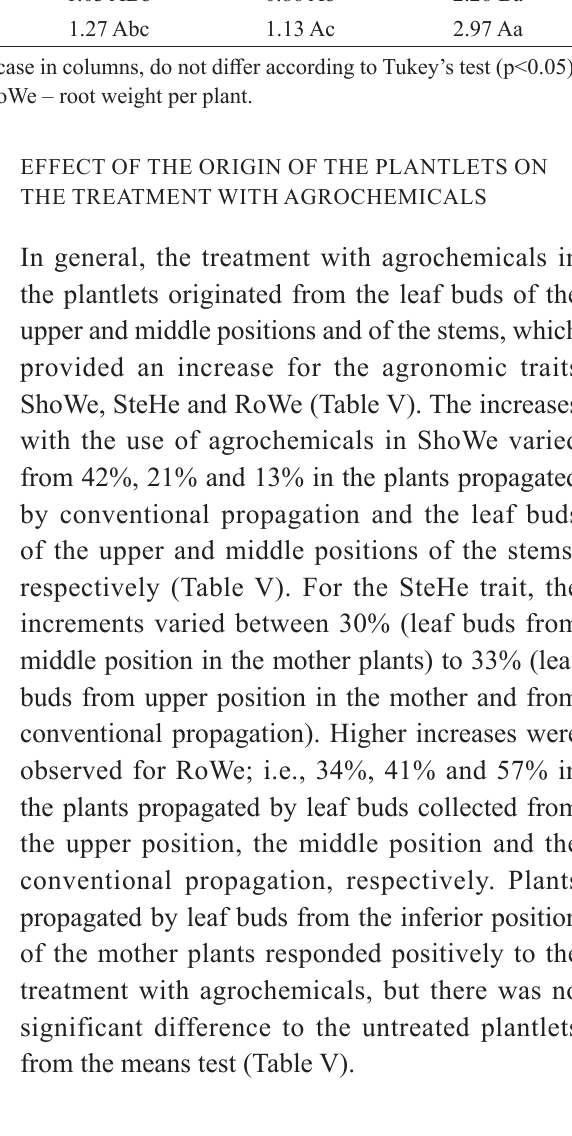
AGRONOMIC PERFORMANCE OF PLANTLETS FROM LEAF BUDS